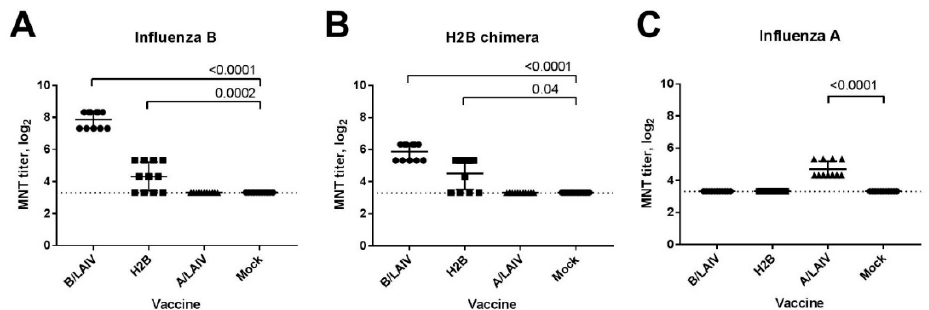
Figure 7. Sera neutralizing activity after immunization with LAIVs studied. Neutralizing antibody titers were assessed in MNT 3 weeks after 2nd immunization, with 3 viruses: ( A ) B/Brisbane/60/2008; ( B ) H2B chimeric LAIV; ( C ) A/17/New York/2015/5364. Significant differences are indicated (Kruskal–Wallis ANOVA, Dunn’s multiple comparisons test).